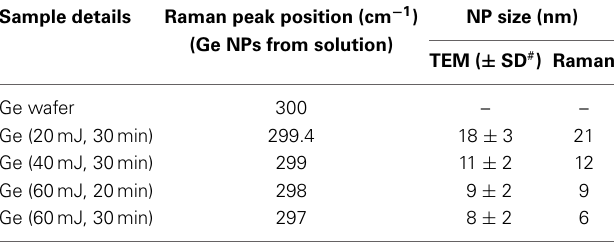
Table 1 | Comparison of Ge Nanoparticle sizes of different samples measured from TEM and Raman spectroscopy (phonon confinement